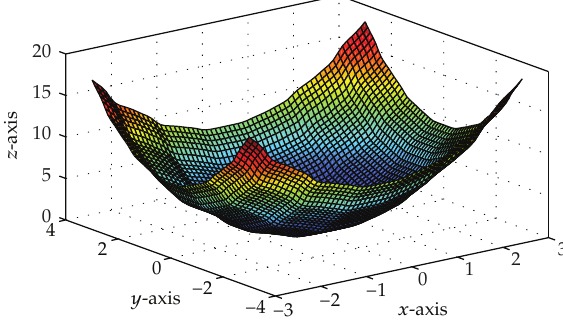
Figure 7: C 1 rational trigonometric bicubic function with α i (cid:8) 7 , β i (cid:8) 7 , γ i (cid:8) 7 , δ i (cid:8) 7 , (cid:28) α j (cid:8) 3 , (cid:28) δ 3 , and j (cid:8) 3.